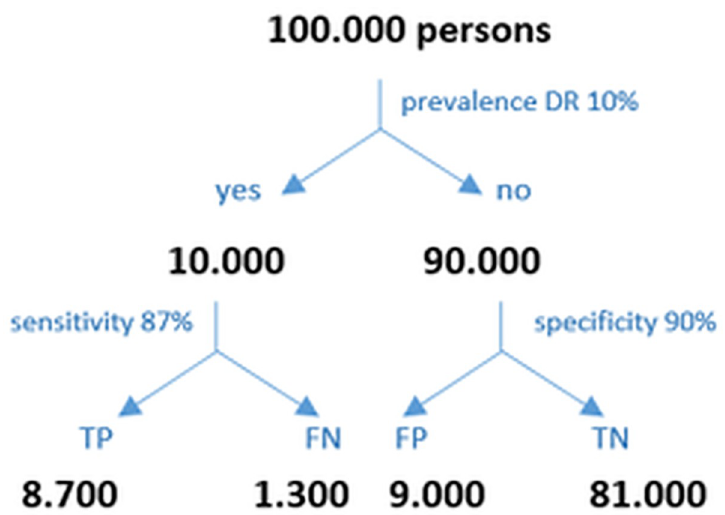
Fig 5. Positive and negative predictive values of DR for patients with diabetes type 2: (TP) true positive, (TN) true negative, (FP) false positive, (FN) false negative, (ppv) positive predictive value, (npv) negative predictive value. ppv = TP/(TP+FP) = 49% of all positively tested diabetes patients, 49% have a true DR and 51% do not. npv = TN/(TN +FN) = 98% of all negatively tested diabetes patients, 98% are truly negative for DR, while 2% are not.